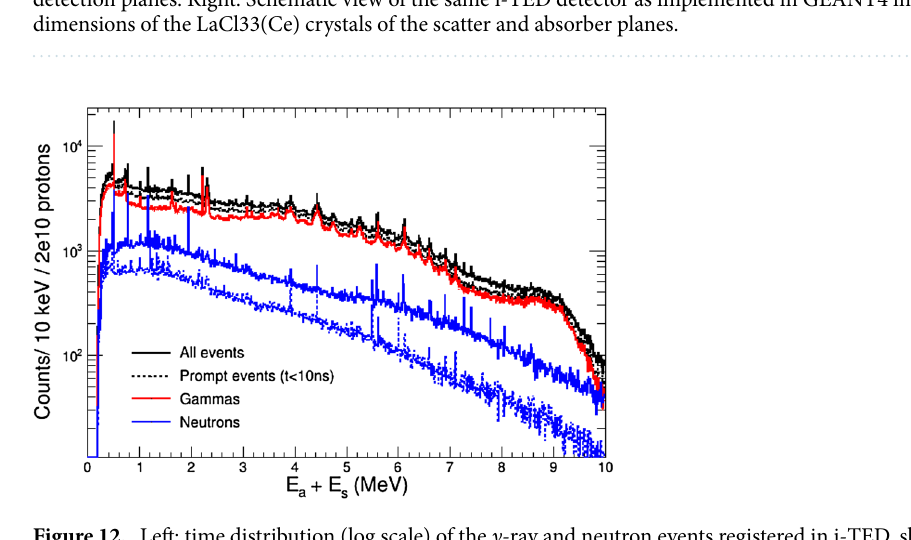
Figure 12. Left: time distribution (log scale) of the γ -ray and neutron events registered in i-TED, showing three distinct components which are separated by vertical dashed lines (see text for details). Right: add-back energy spectrum for all and prompt (t < 10 ns)